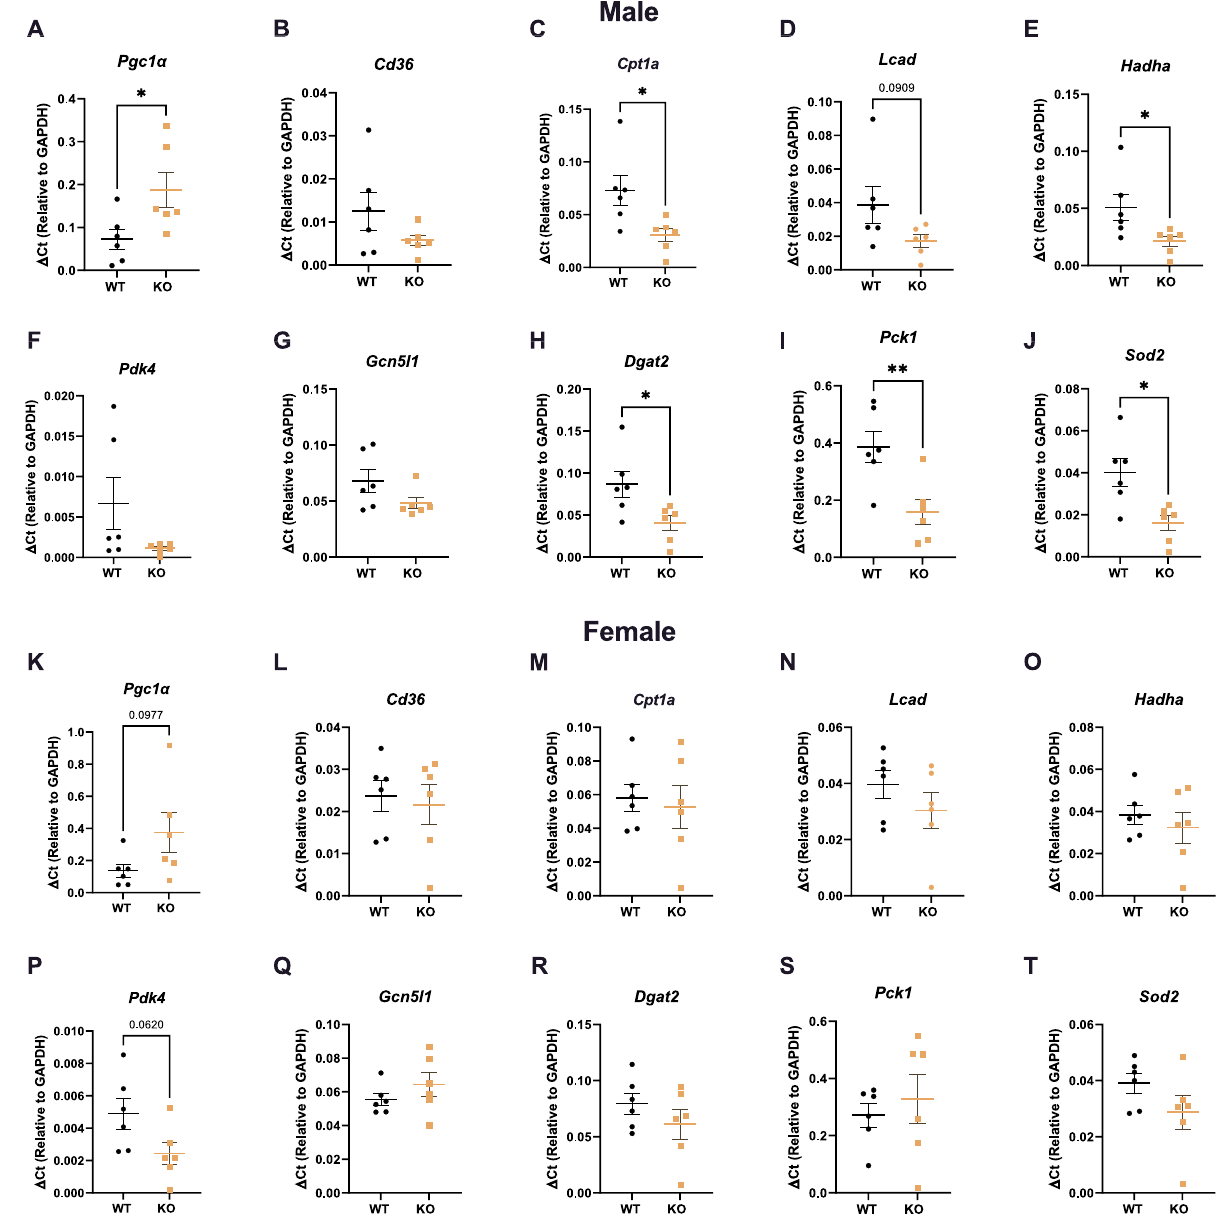
Figure 4. Whole-body GPR19 deficiency results in transcriptional changes in lipid and glucose metabolism genes. After a 10-week HFD, male ( A–J ) and female ( K–T ) wildtype or GPR19 KO mice were analyzed for the expression of hepatic metabolism genes. * P < 0.05, ** P < 0.01, N =